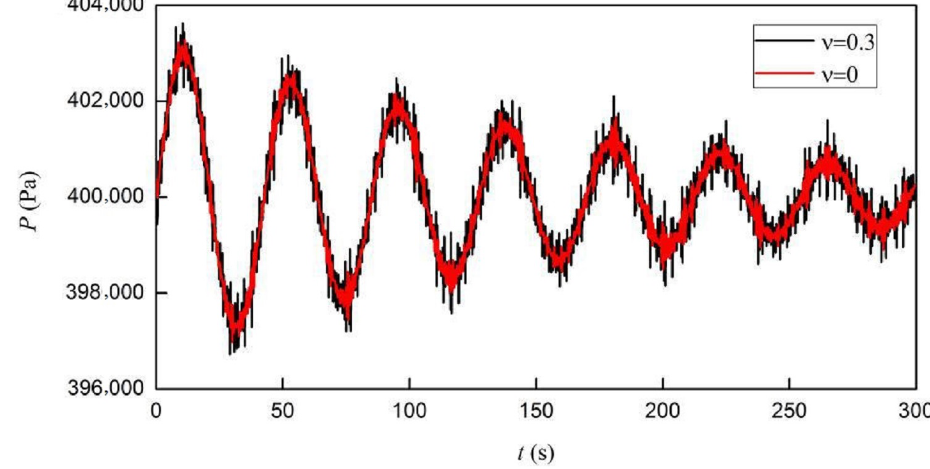
Figure 14. Time history of pressure at the bottom of surge chamber with and without Poisson